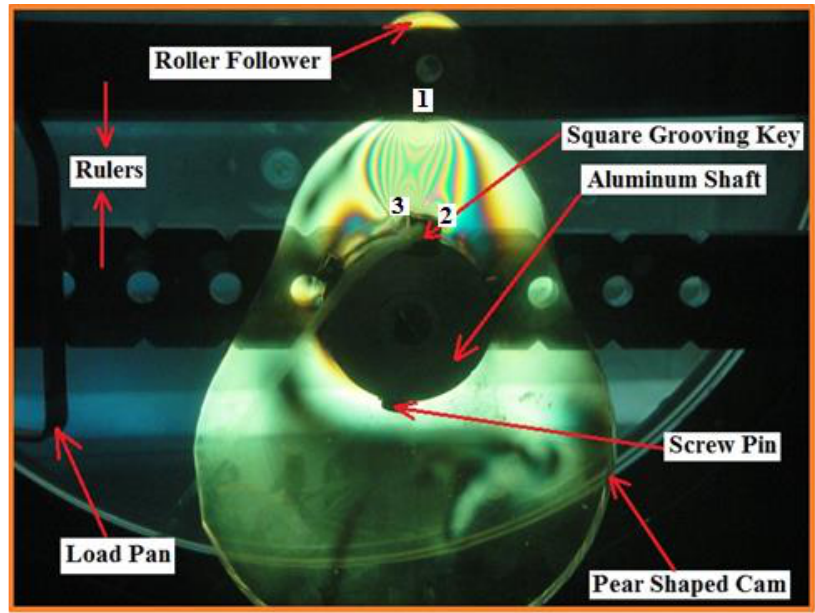
Figure 12. Experimental analysis of the stress distribution when the follower comes in contact with the nose.